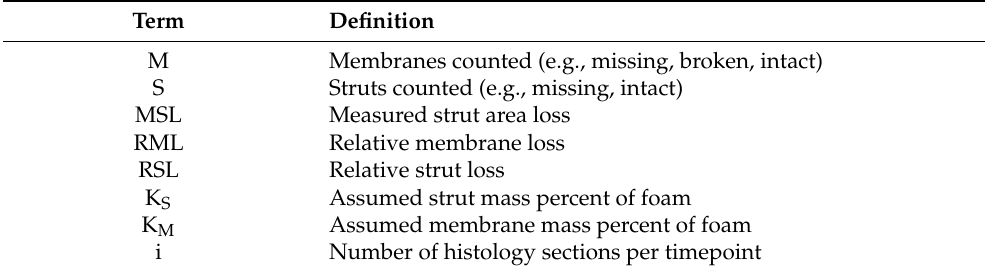
Table 3. Representative mathematical terms used in Table 4 and their corresponding definitions.